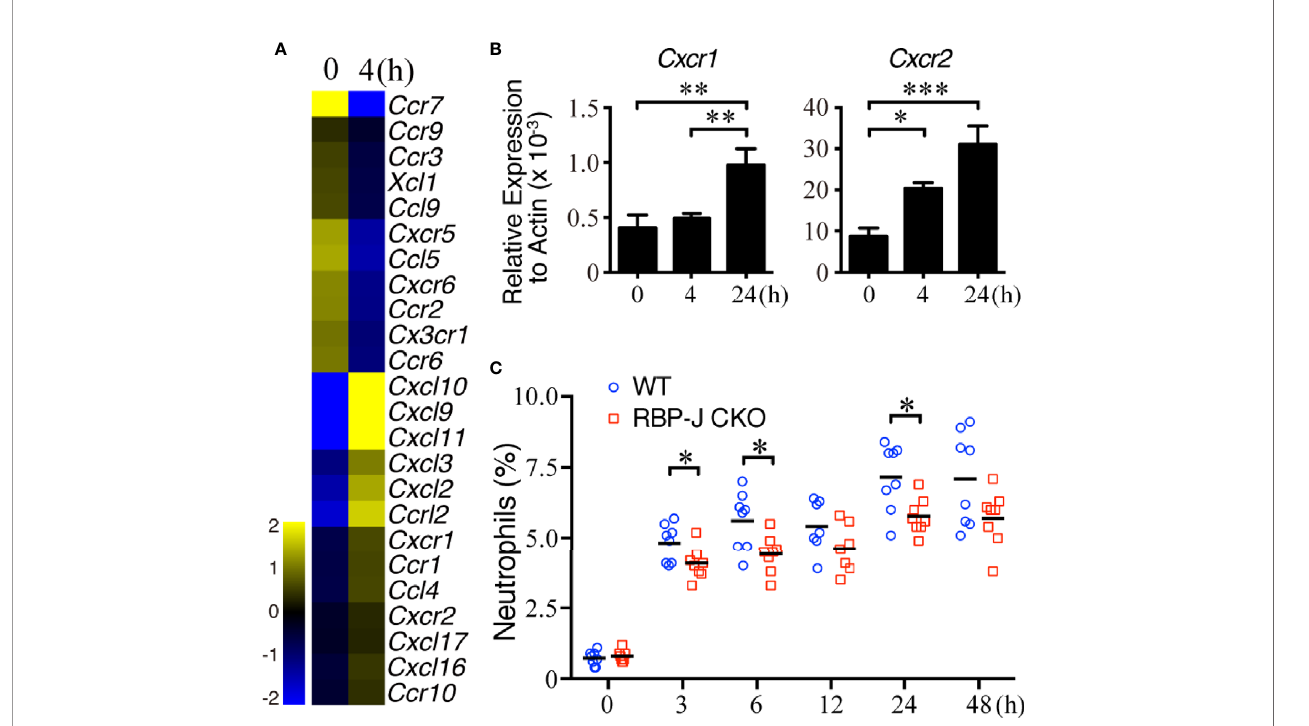
FIGURE 3 | Cxcr1/Cxcr2 levels in splenic neutrophils after systemic S. aureus infection. (A) Heatmap from a cDNA microarray analysis showing the changes in chemokine-related genes between splenic neutrophils isolated before and 4 h after infection with S. aureus (2.5 × 10 6 CFU) by iv injection. The expression of chemokine-related genes with fold changes of >1.5 is shown. (B) RT-qPCR analysis showing the expression of Cxcr1 / Cxcr2 mRNA. Splenic neutrophils were isolated at 0, 4, or 24 h after S. aureus infection. Results were normalized to the actin mRNA levels. Three independent experiments were performed. Data are presented as the mean ± SEM (n = 6 – 8 mice per group). One-way ANOVA was used for comparison. (C) Flow cytometric analysis showing the frequency of splenic neutrophils (Ly6G hi CD11b hi ) in WT and RBP-J CKO mice at various timepoints after S. aureus (2.5 × 10 6 CFU) infection. Data are presented as the mean ± SEM (n = 7 – 8). An unpaired two-tailed t -test was performed. * p < 0.05, ** p < 0.01, and *** p <